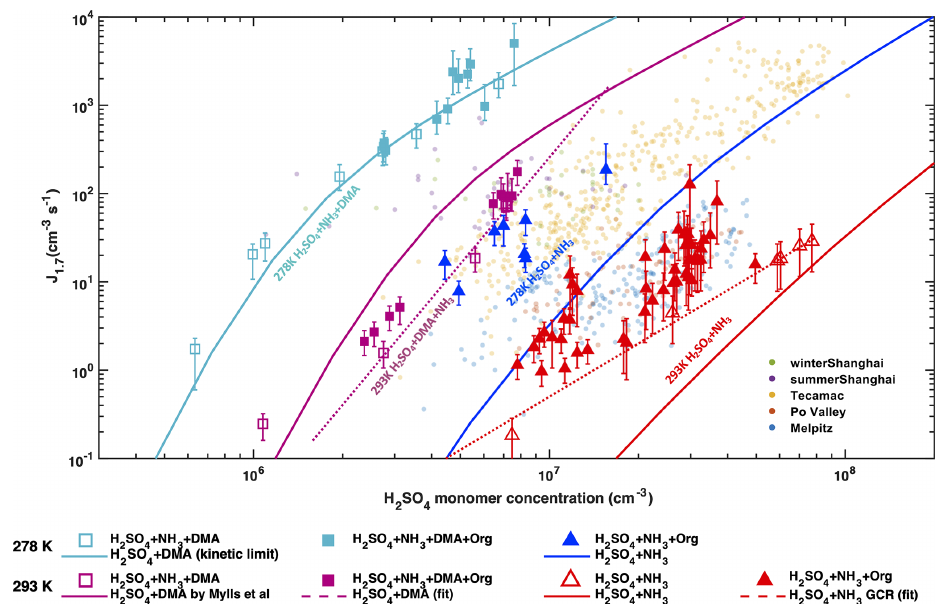
Figure 1. Dependencies of atmospheric particle formation rates ( J 1 . 7 ) on sulfuric acid. J 1 . 7 versus H 2 SO 4 measured in CLOUD at 278K (blue and cyan) or 293K (red and magenta) with 1 to 2ppbv NH 3 . Experiments without DMA injection are shown by triangles and those with 4pptv DMA by squares. Filled and open symbols indicate presence or absence of anthropogenic organics, respectively, where the variability of the filled symbols is mostly due to different concentrations of oxidized organics (OxOrg) from NAPH, TMB and TOL oxidation, and NO x . Over the range of 10 6 to 10 8 cm − 3 sulfuric acid, J 1 . 7 increases from 1 to 10 4 cm − 3 s − 1 . The error bars indicate the measurement uncertainty of the nucleation rates. Atmospheric observations in the polluted boundary layer are indicated by small coloured circles (Kuang et al., 2008; Paasonen et al., 2010; Yao et al., 2018). Solid lines show the predicted nucleation rates of sulfuric acid and 2ppbv ammonia at 278K (blue) and 293K (red) from the kinetic model. The nucleation rate of H 2 SO 4 –NH 3 under GCR conditions is given by the red dashed line. The nucleation rate of H 2 SO 4 at the kinetic limit is indicated by the solid cyan curve, which matches our H 2 SO 4 + DMA experiments. The solid magenta line is the predicted nucleation rates of sulfuric acid and 4pptv DMA at 293K and the magenta dashed line shows a fit of J 1 . 7 = k [H 2 SO 4 ] 4 to the data with 4pptv DMA at